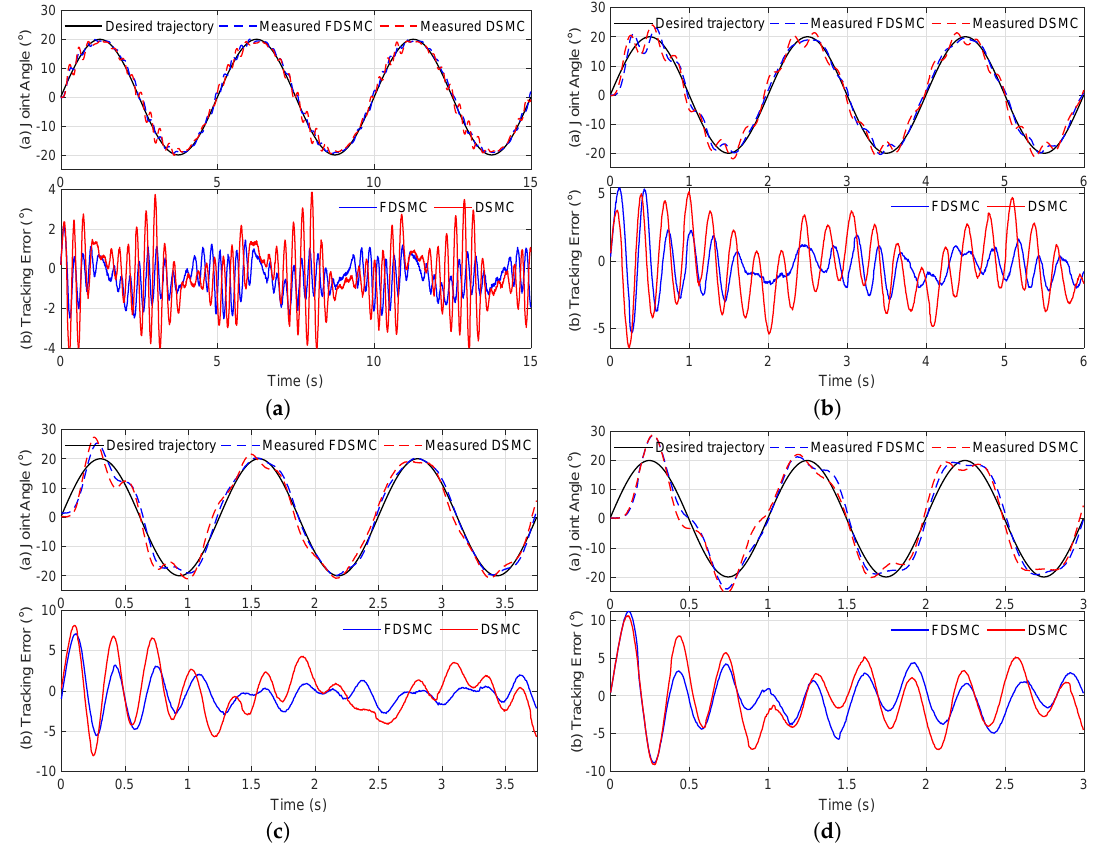
Figure 7. Experiment results with 2.5 kg of load for tracking a sinusoidal trajectory: ( a ) 0.2 Hz, ( b ) 0.5 Hz, ( c ) 0.8 Hz, and ( d ) 1.0 Hz of the desired signal frequency.